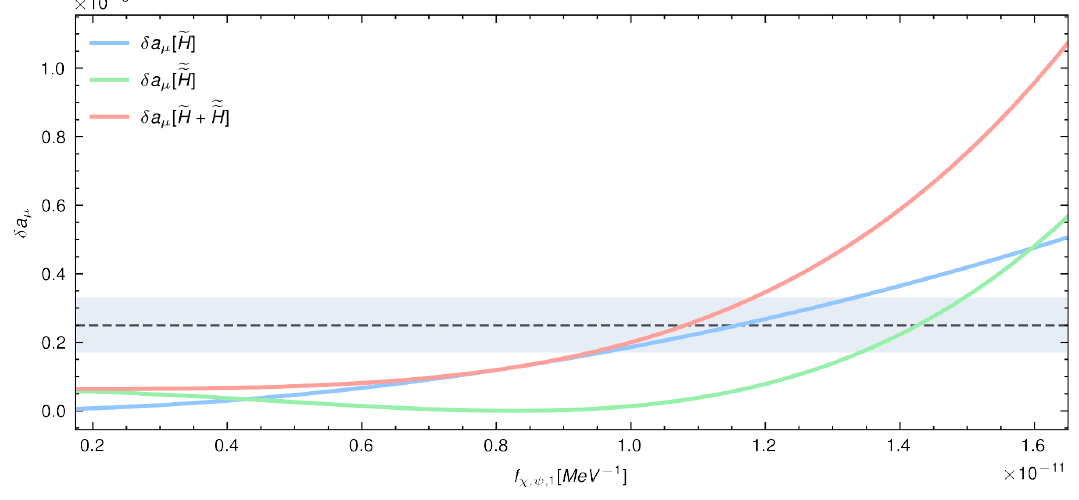
Figure 9 . Contributions to the δa µ coming from the first and second excited states ˜ h and ˜˜ h , in terms of the length f χψ, 1 , for fixed angles a 1